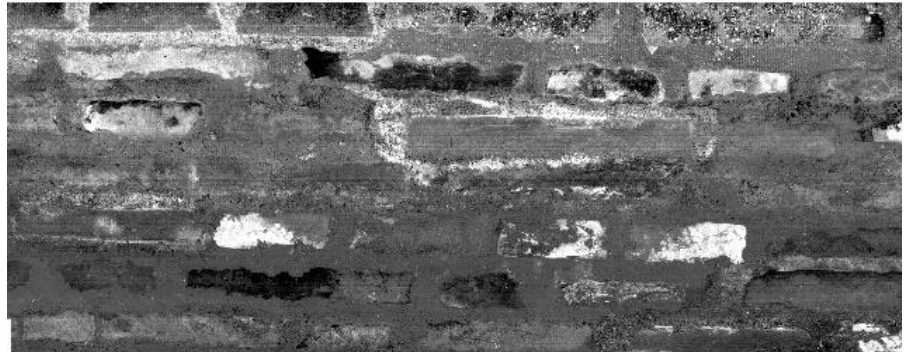
Figure 9. LSU classification for the adherent deposit layer.